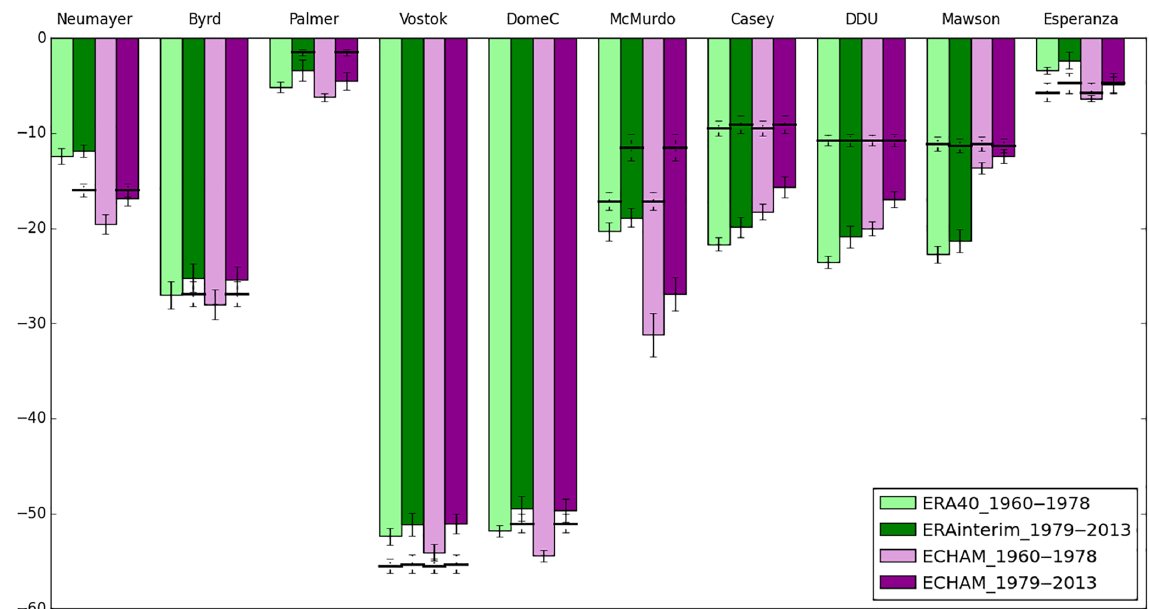
Figure 3. The 2m temperature outputs (in ◦ C) from ERA-40 (light green), ERA-Interim (dark green), and ECHAM5-wiso outputs over the periods 1960–1979 (light purple) and 1979–2013 (dark purple) at the locations of Neumayer, Byrd, Palmer, Vostok, Dome C, McMurdo, Casey, Dumont d’Urville (written as DDU), Mawson, and Esperanza stations. Horizontal black lines correspond to the mean data. Vertical black lines correspond to inter-annual standard deviations: dotted lines are associated with data, while solid lines are associated with model outputs (ERA or ECHAM). Table 1. Differences between observed (READER) and simulated (ECHAM5-wiso) annual surface air temperature: observed average (noted as “observed µ ”, in ◦ C), average difference (noted as “ µ differences”, in ◦ C), standard deviation from observations (noted as “observed σ ”, in ◦ C), and standard deviation from the model (noted as “simulated σ ”, in ◦ C) for the period 1979–2013. Neumayer Mawson Vostok Casey Dome C DDU McMurdo Byrd Palmer Esperanza Observed µ ( ◦ C) − 16.0 − 11.2 − 55.4 − 9.2 Observed σ ( ◦ C) Simulated σ ( ◦ C)